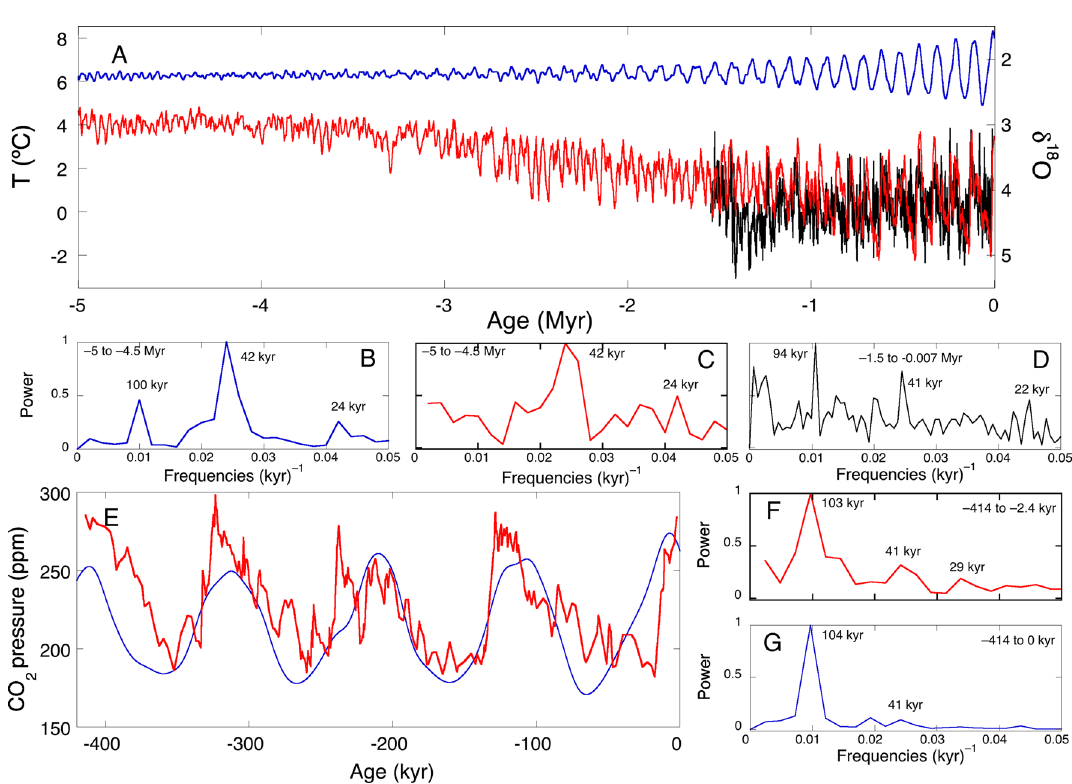
Figure 7. ( A ) Benthic δ 18 O records of the LR04 stack (red) 7 matched to temperatures derived from Mg/Ca ratios of benthic foraminifera (black) 9 and temperatures calculated from changes in CO 2 radiative forcing with S = 1.35 °C/(W/m 2 ) added to the pre-industrial global surface land temperature T s = 8 °C (blue), and ( B , C , D ) their frequency distributions. ( E ) Historical (red) 11 and Glaciator (blue) changes in atmospheric concentration of CO 2 , and ( F , G ) their frequency